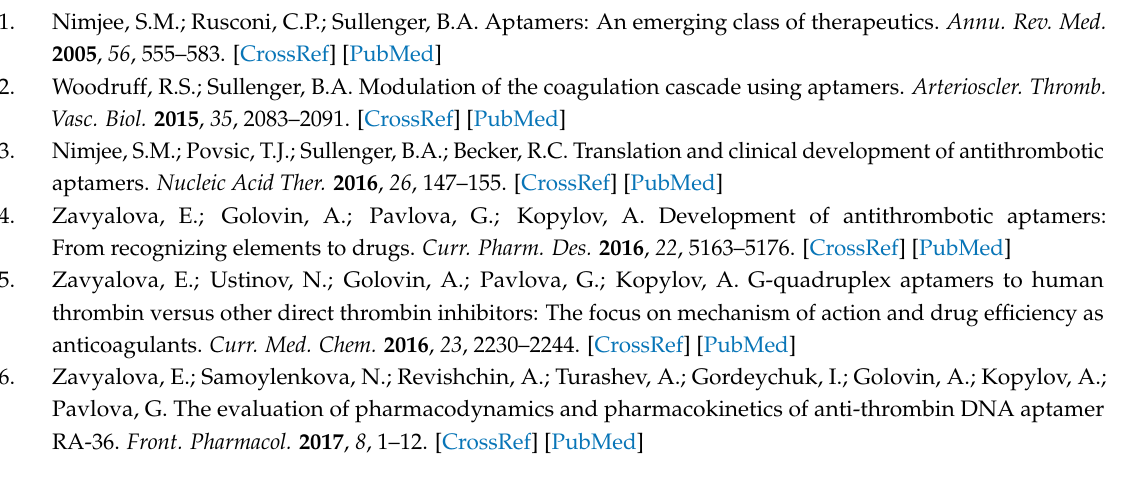
Table S1: Description of aptamers studied, Figure S1: Chromatograms of SEC HPLC; Table S2: Oligomeric composition of aptamer HD1, complementary oligonucleotide and their duplex estimated in SEC experiments; Table S3: Melting temperatures of aptamer structures derived from CD spectra; Table S4: Melting temperatures of aptamer structures derived from UV spectra; Figures S2 and S3: Melting curves derived from CD spectra and their linearization in coordinates lnK (1/T); Figures S4 and S5: Denaturation-renaturation experiments for G-quadruplex and duplex modules: 31-TBA, NU172, jja, aaj, and HD1; Table S5: Detailed analysis of polar contacts in the interface of complexes of thrombin and